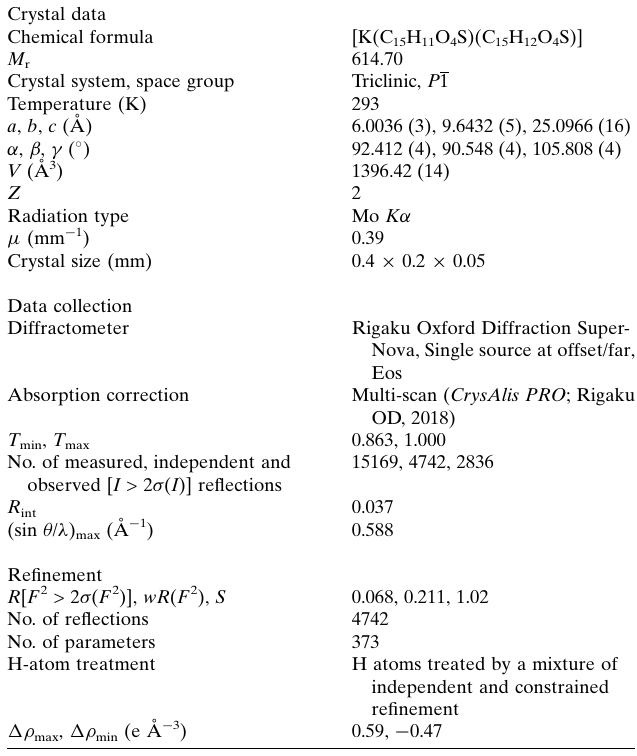
Table 3 Experimental details. Crystal data Chemical